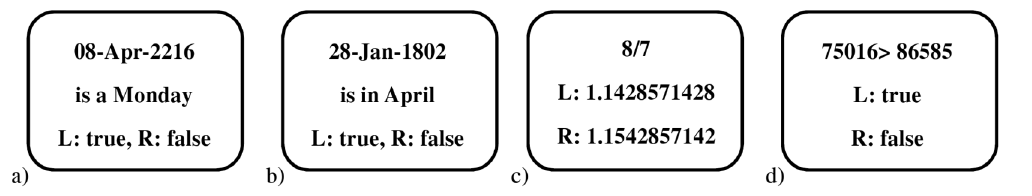
Figure 1. Example trials for the calendrical task (a) and its control (b), and for the division task (c) and its control (d) as they appeared on the screen. L and R, correspond to left and right response button respectively. See section 2.2 Methods, Experimental tasks, for